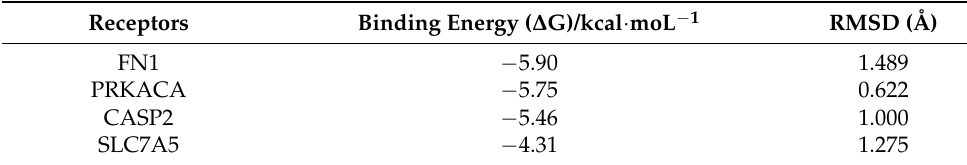
Table 7. The results of molecular docking between receptors and ligand.